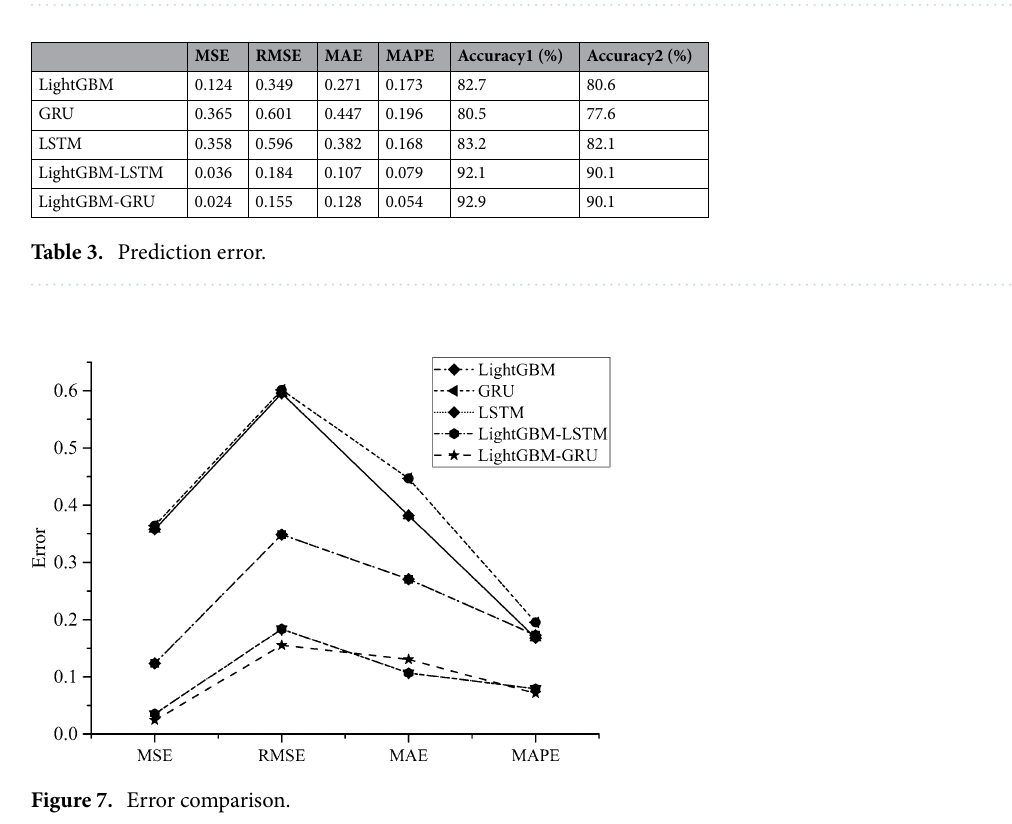
Figure 6. Comparison of model results.